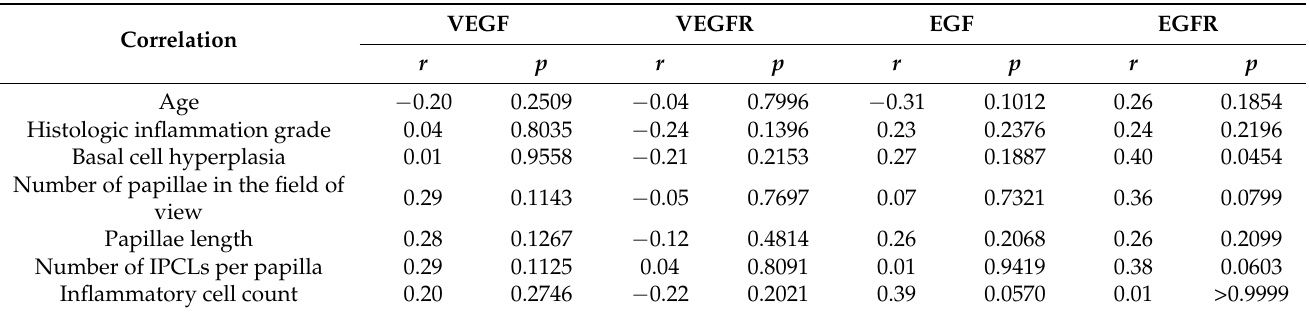
Table 3. Correlation of VEGF, VEGFR, EGF, and EGFR expressions with quantitative endoscopic and histologic